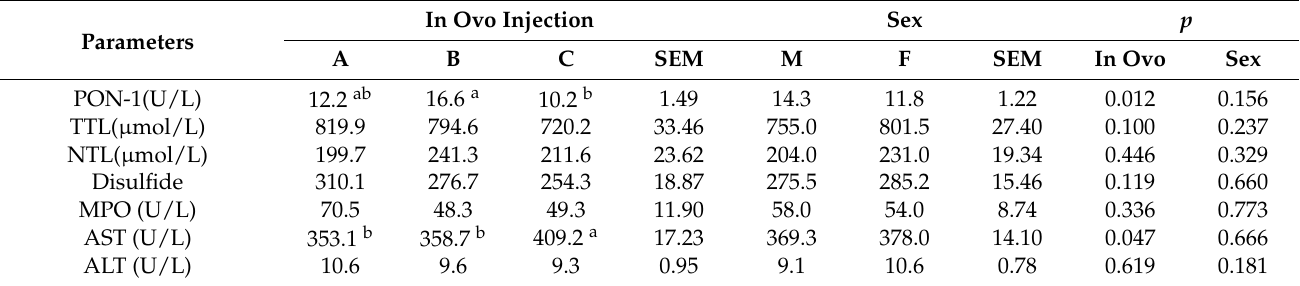
Table 7. The effects of in ovo injection of vitamin C and sex on blood metabolites of broiler chicks at market age (day